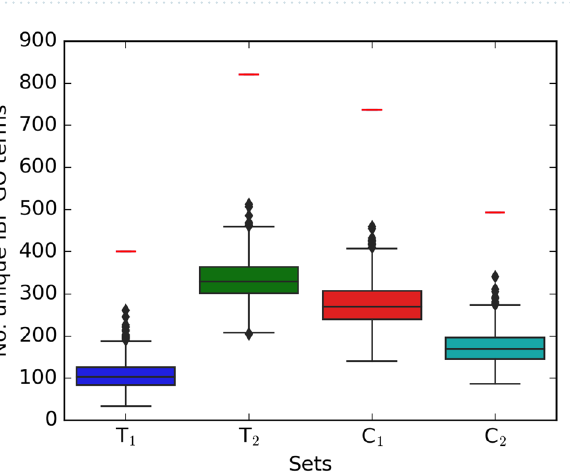
Figure 2. ( a ) Boxplot of the degrees in protein–protein interaction (PPI) network for T 1 , T 2 , C 1 , and C 2 sets; ( b ) Boxplot of the number of unique IBP GO terms resulted from each of the four sets. The complete description of sets is presented in Table 1.